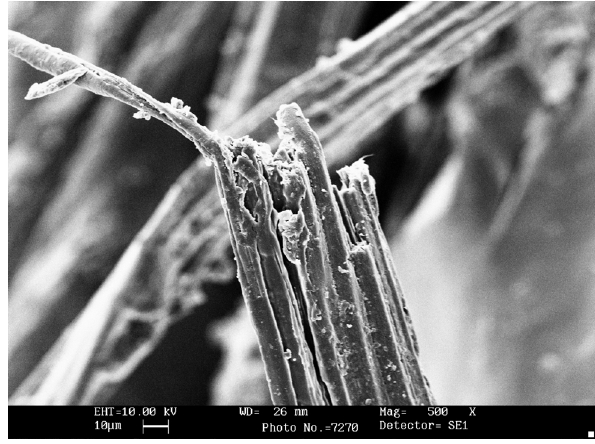
Figure 20: SEM for (5% jute fiber by weight) composite material with coating.